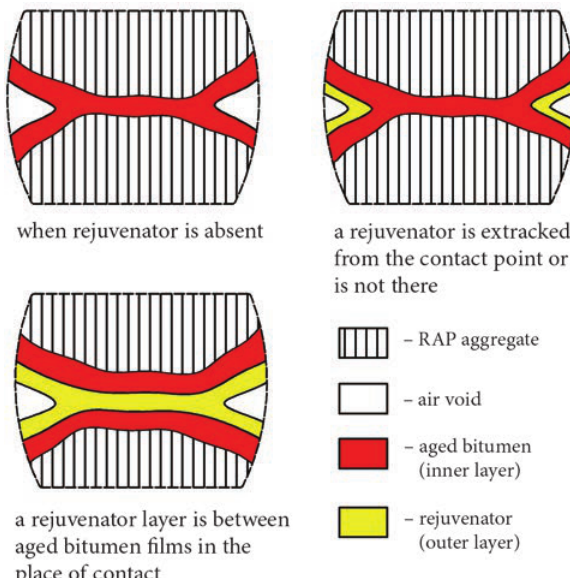
Fig. 3. The structure of the bitumen film in the place of the contact of two adjacent particles in the